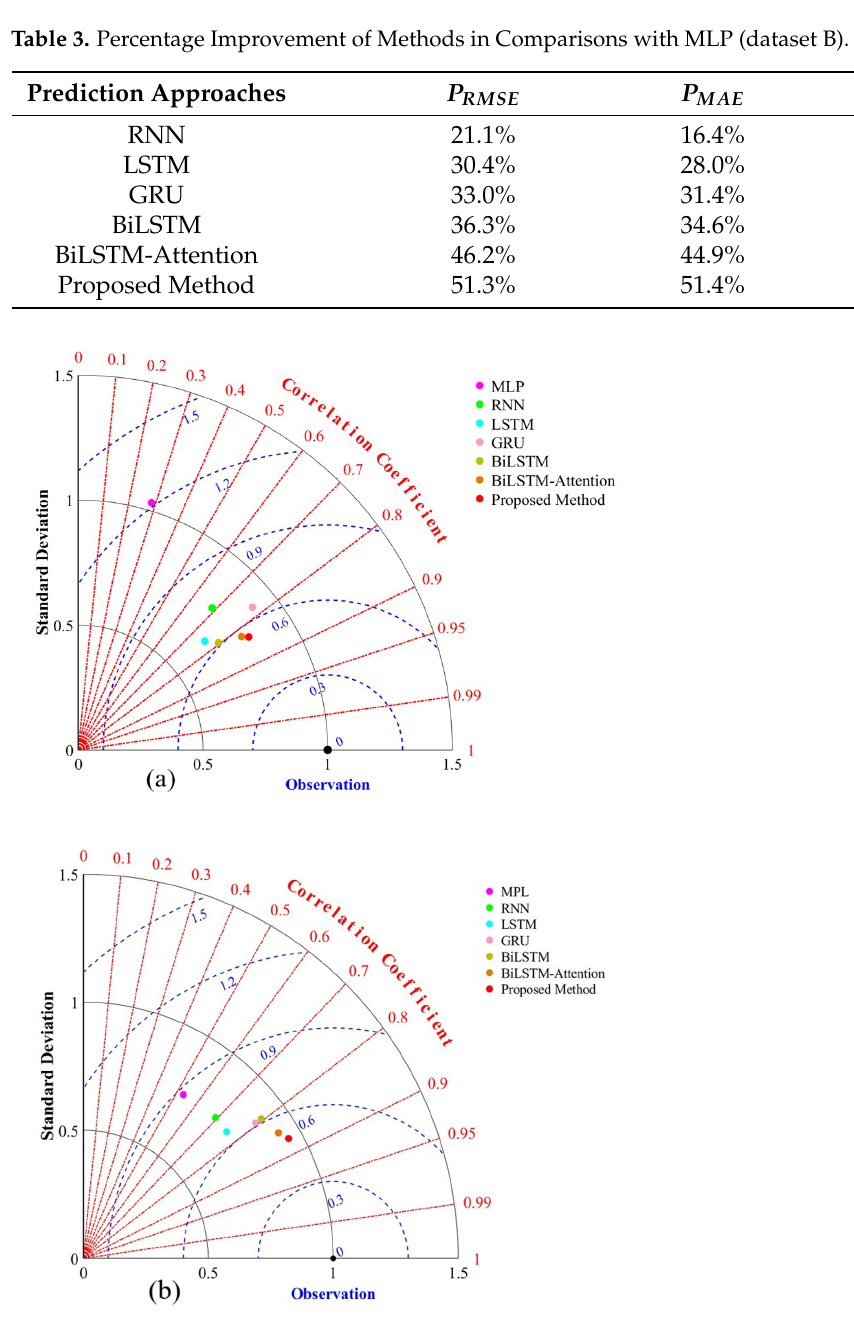
Figure 9. Taylor diagram of different models in ( a ) dataset A and ( b ) dataset